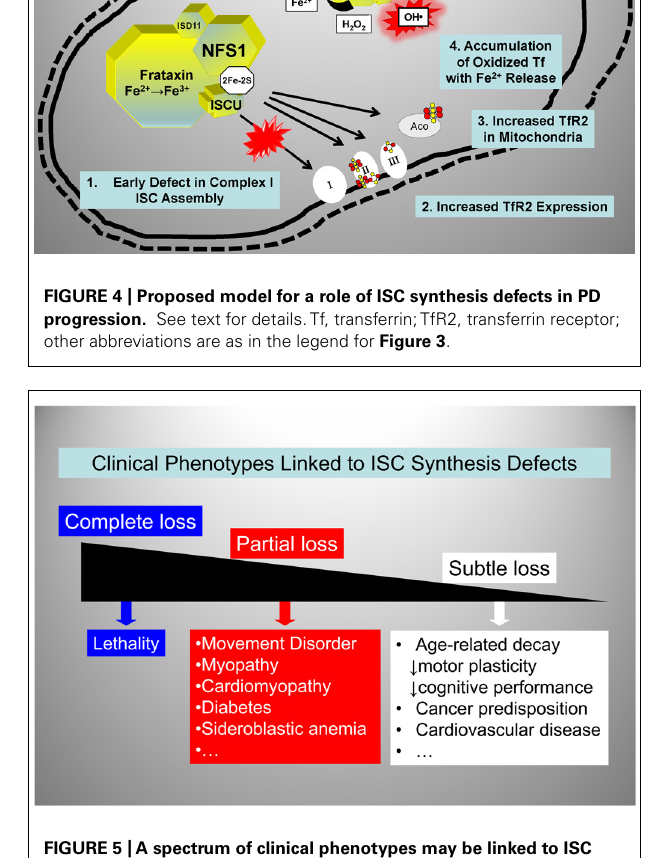
FIGURE 5 |A spectrum of clinical phenotypes may be linked to ISC synthesis defects. ISC synthesis defects of decreasing severity lead to a variety of clinical phenotypes ranging from embryonic lethality to increased predisposition to age-related